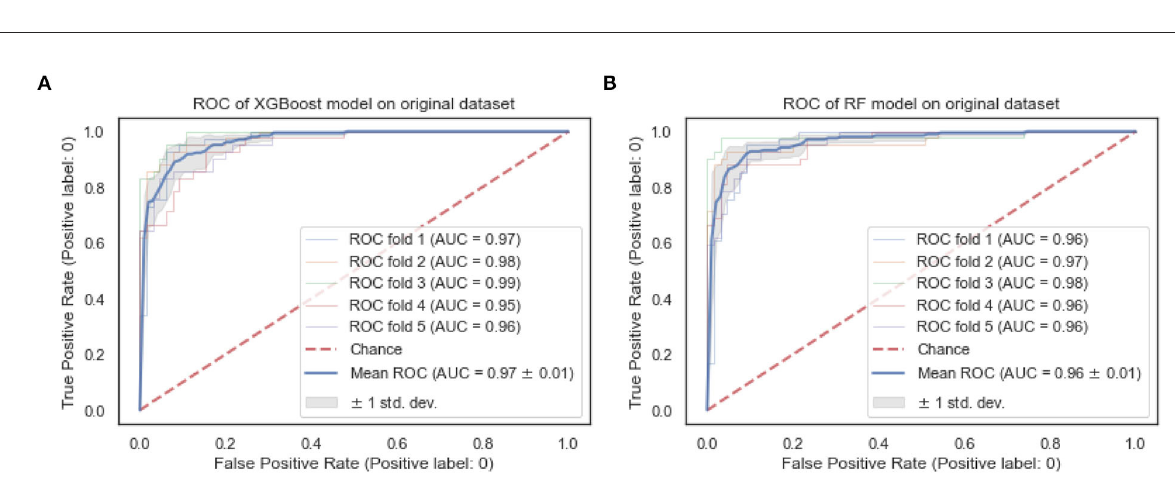
FIGURE4 ROC curves of XGBoost and random forest on the original dataset. (A) XGBoost. (B)